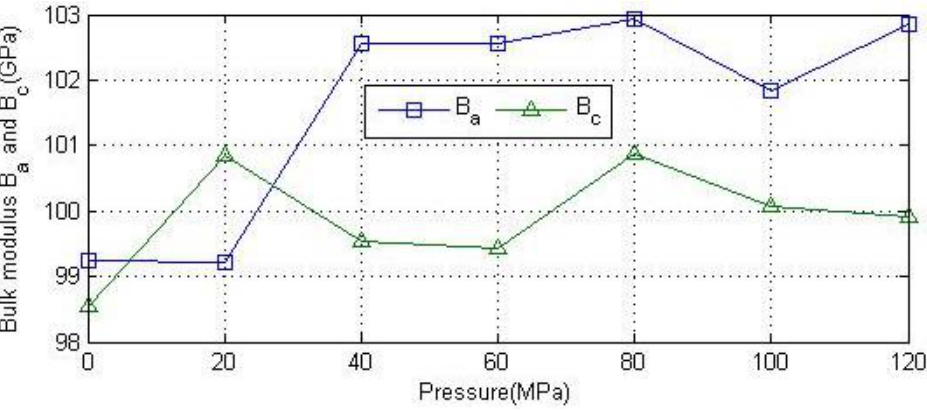
Figure 9. Relationship between bulk modulus and pressure along the a and c axes under uniaxial compression.